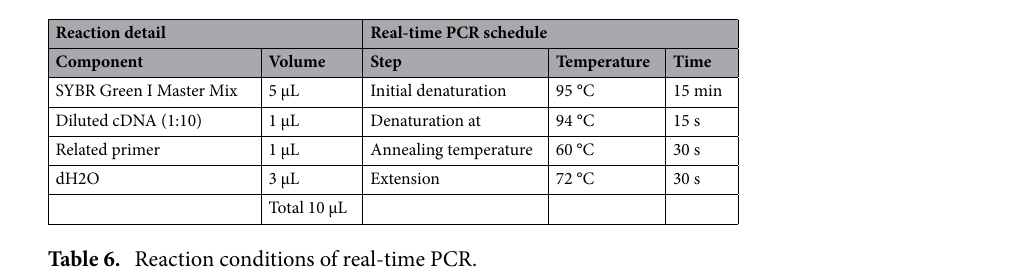
Table 6. Reaction conditions of real-time